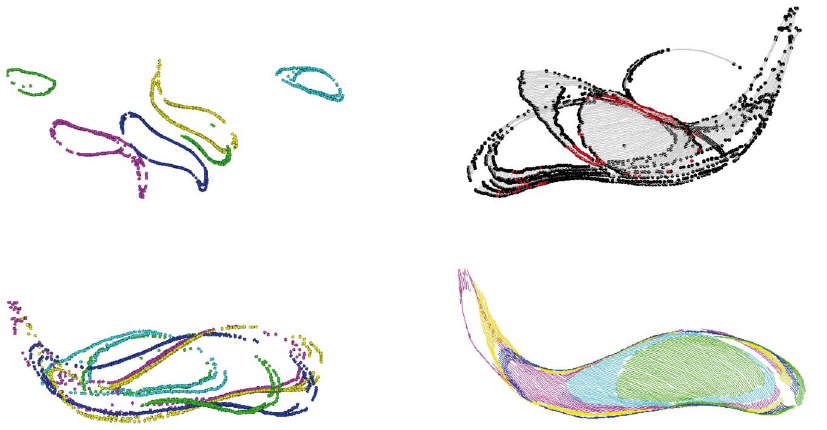
Figure 10. Alignment of T. brucei . The view is from the top. Unless stated otherwise, colors indicate 6 different sections. The stacking order is best seen in the final result (bottom right) at the right side: green, cyan, purple, yellow, blue, green. The length of the microtubule array is approximately 8 m m. Top left: initial position of unaligned sections. Only endpoints are displayed. Top right: The result after applying the initial alignment algorithm. Endpoints in all sections are depicted in black; lines in gray. The subset of endpoints that were used for computing the transformation are highlighted in red. Some pairs of sections are reasonably aligned. Other pairs are unaligned. Bottom left: endpoints after applying our algorithm for linear alignment from orientation (Figure S1). All sections are reasonably rotated. Bottom right: result after applying our algorithm for linear alignment from position and orientation (Figure S2). Endpoints and lines are displayed, both colored by section. All sections are reasonably